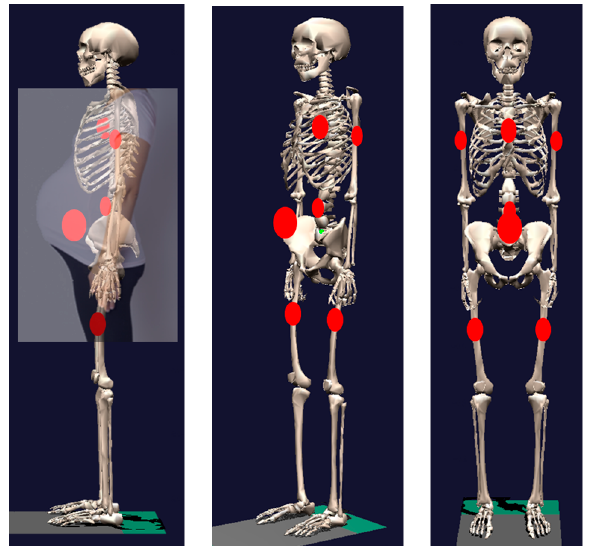
Figure 5. Points of additional mass for the musculoskeletal model for pregnant women. The red circles indicate the points where there is increased